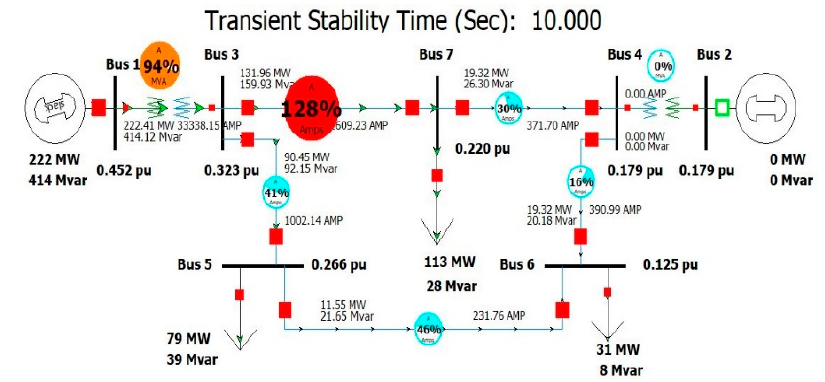
Figure 14. Transient stability power flow solution for the second contingency scenario.